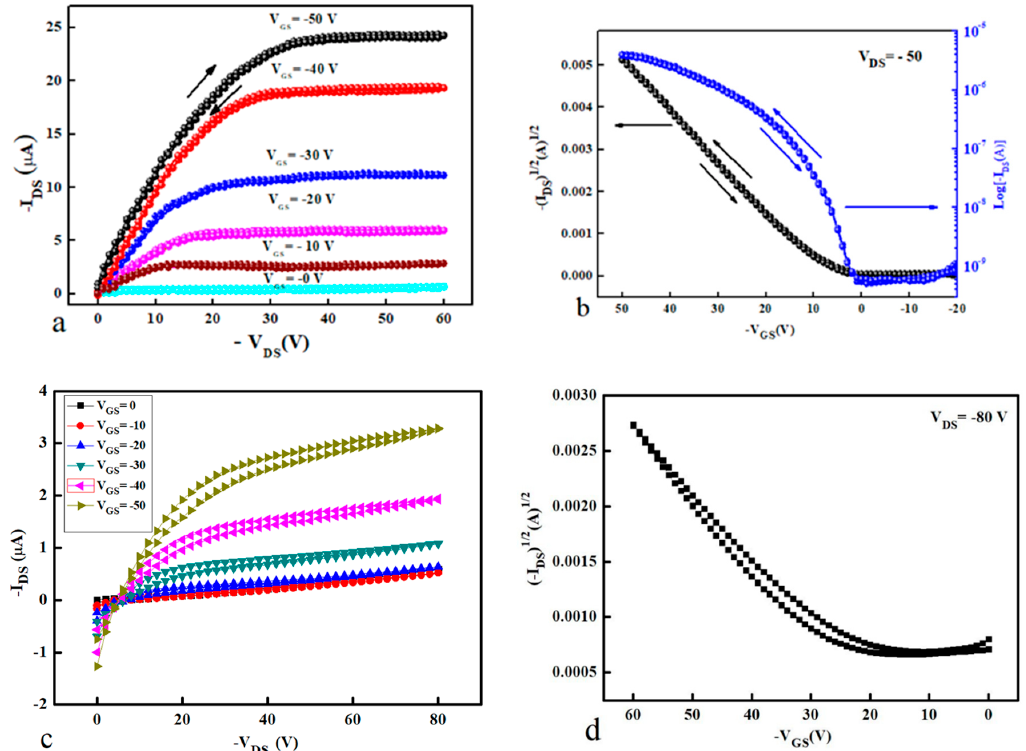
Figure 3. Output and transfer characteristics of the organic thin film transistors (OTFTs) fabricated, ( a ) and ( b ) optimised devices using off-centre technique and ( c ) and ( d ) for devices with cPMMA fabricated using on-centre conventional deposition technique.